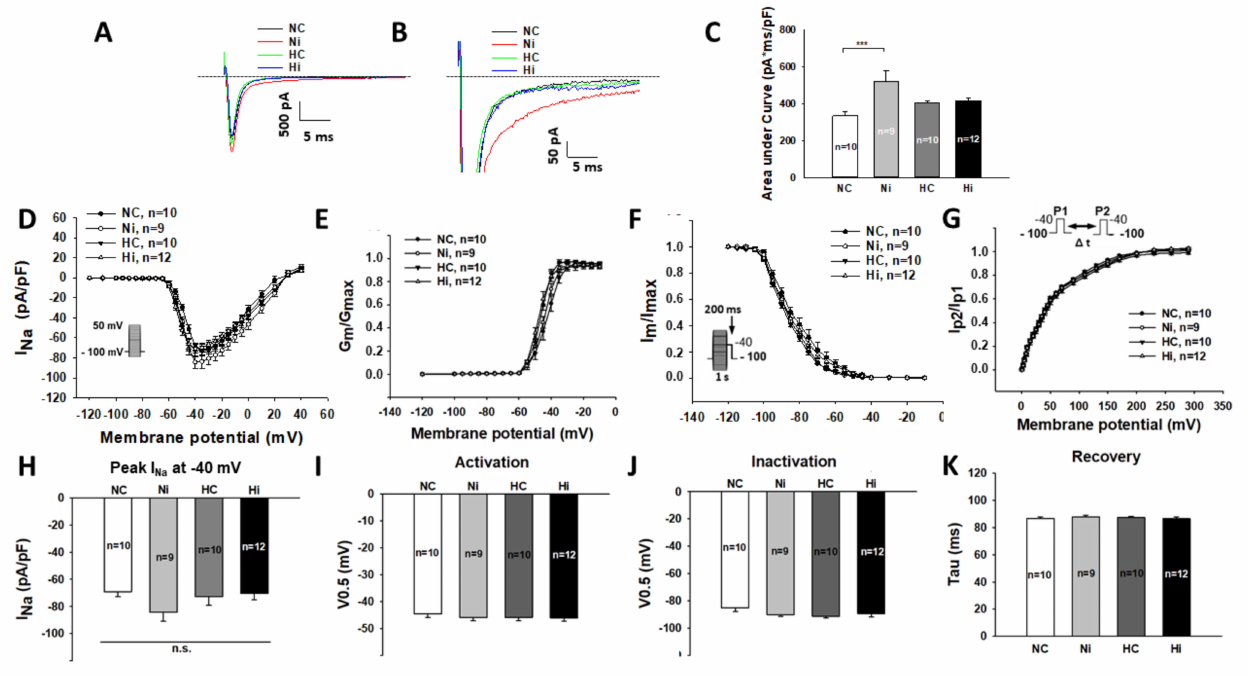
Figure 2. Effectsofhigh-concentrationisoprenalineandahighlevelofglucoseonsodiumchannelcurrents. “NC” represents data from hiPSC-CMs treated with normal level of glucose. “Ni” represents data from hiPSC-CMs treated with normal level of glucose and a high concentration of Iso. “HC” represents data from hiPSC-CMs treated with a high level of glucose. “Hi” represents data from hiPSC-CMs treated